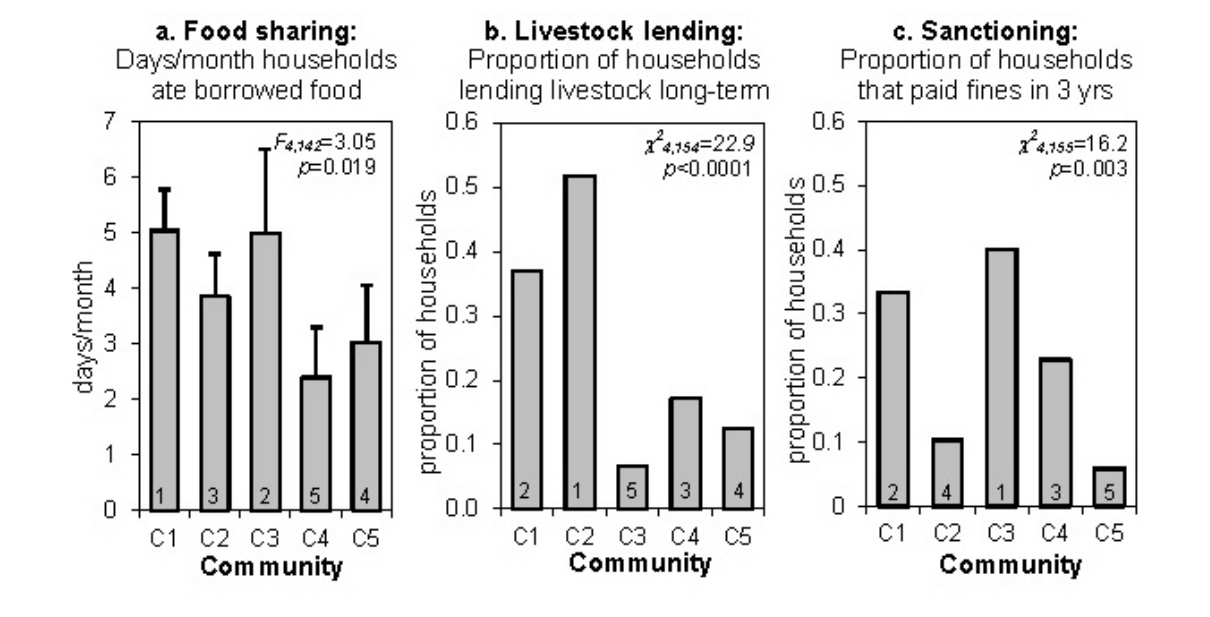
Fig. 4 . Indicators of traditional forms of social capital varied significantly among study communities. (a) Interhousehold food sharing: respondents reported how many days in the past month they consumed food borrowed from another household (means ± SE). (b) Long-term livestock lending: households reported whether they were currently engaged in the customary practice of lending livestock to other households for several months or years. (c) Sanctioning for rule violations: households reported whether they had been assessed with a fine for rule violation within the past 3 years (until April 2009), which was interpreted as an indicator of a community’s propensity to sanction. Each indicator varied significantly among communities; numbers on bars indicate rank order of communities for each